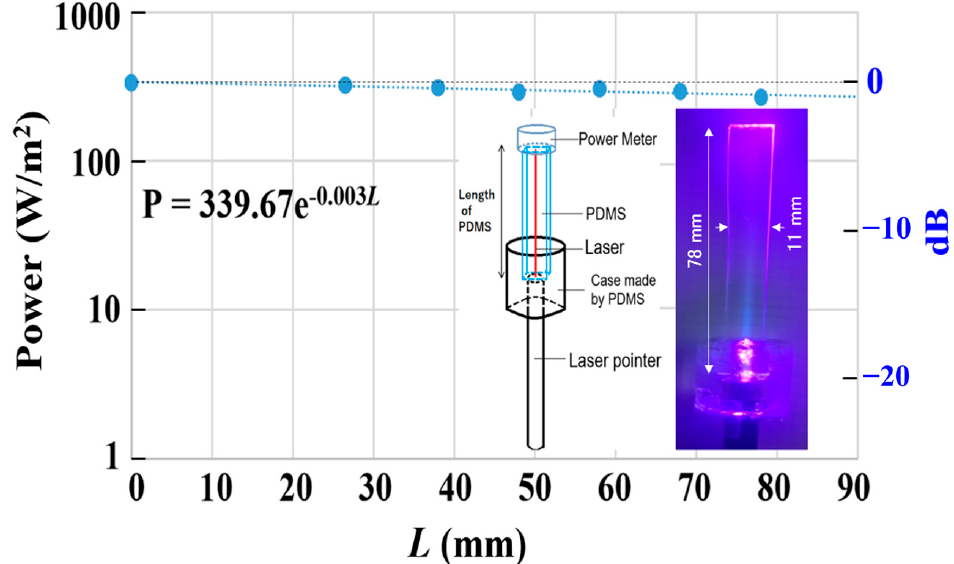
Figure 2. The power of guided light is plotted as a function of the length of the planar PDMS wave- guide with edge light injection for a blue/violet laser beam. The right ordinate shows the ratio of the power at L to that at L = 0 in dB indicating the power loss. Insets are a schematic drawing ( left ) and a picture ( right ) of the experiment.